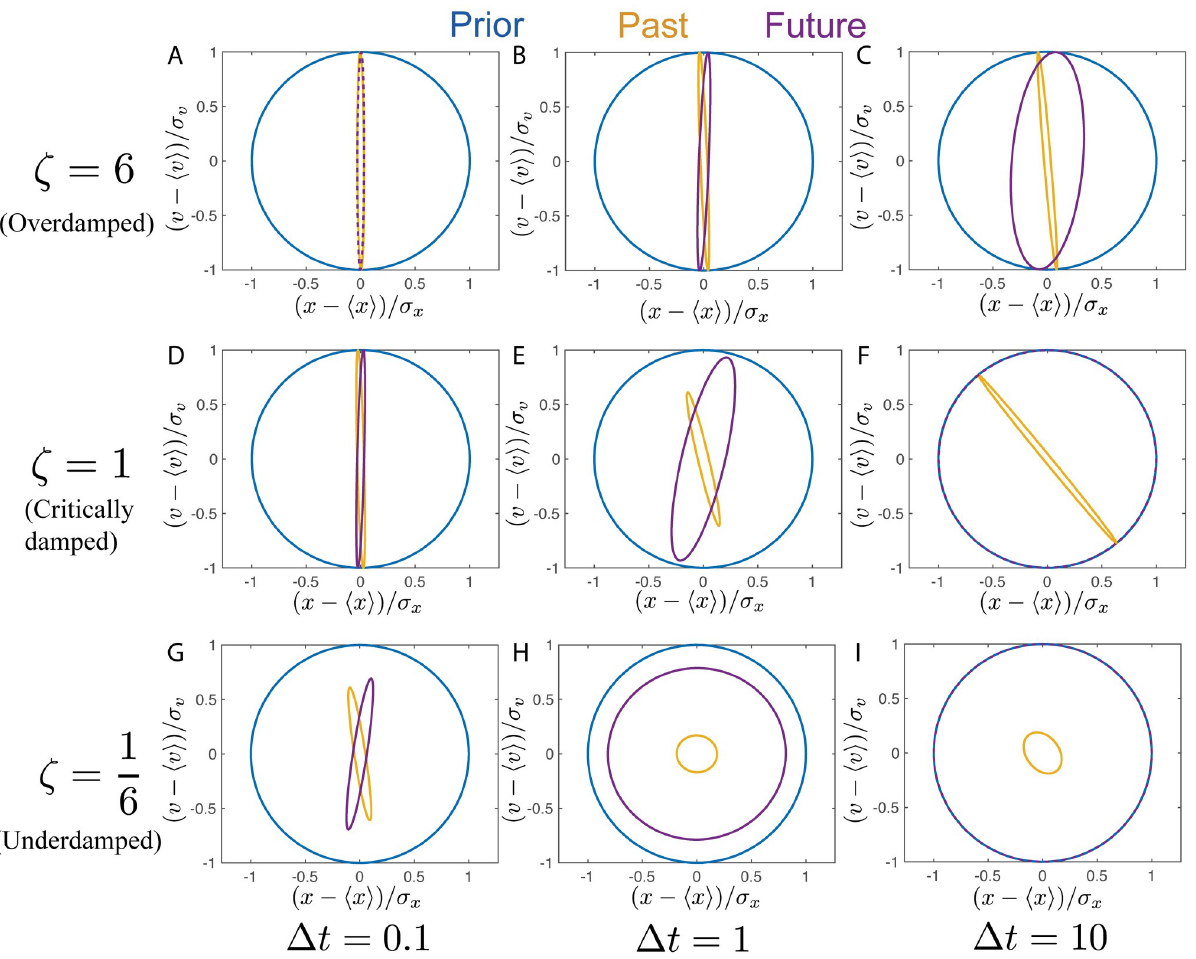
Fig 4. Possible behaviors associated for the SDDHO for a variety of timescales with a fixed I ð X ; ~ X Þ of 5 bits. For an overdamped SDDHO, panel a- t c, the optimal representation continues to encode mostly position information, as velocity is hard to predict. For the underdamped case, panels g-i, as the timescale of prediction increases, the optimal representation changes from being mostly position information to being a mix of position and velocity information. Optimal representations for critically damped input motion are shown in panels d-f. Comparatively, overdamped stimuli do not require precise velocity measurements, even at long timescales. Optimal predictive representations of overdamped input dynamics have higher amounts of predictive information for longer timescales, when compared to underdamped and critically damped